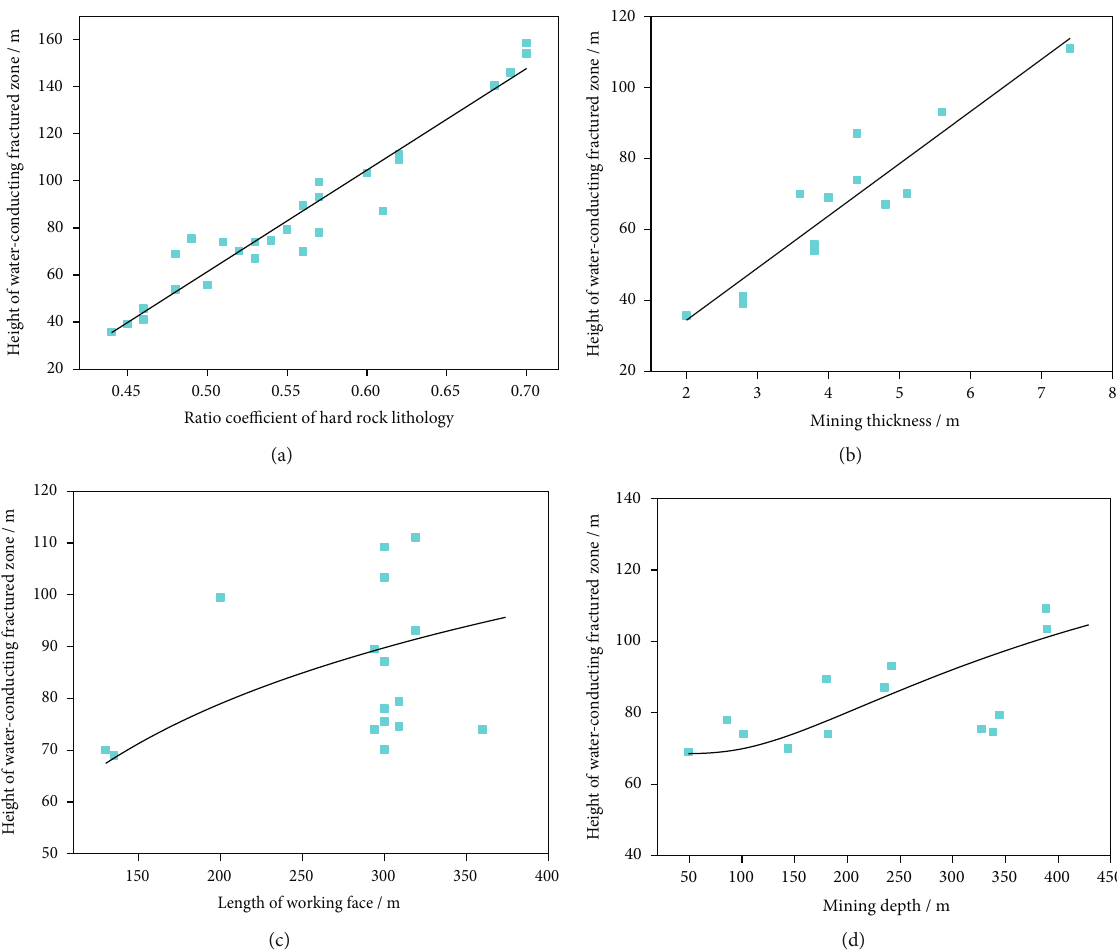
Figure 5: The relationship between the height of the water-conducting fracture zone and in fl uence